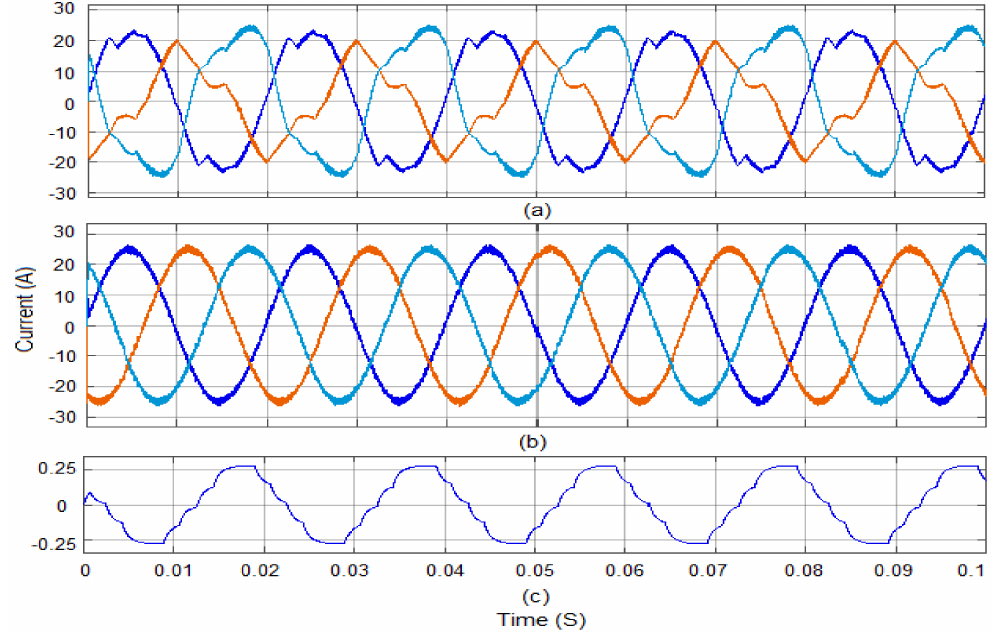
Figure 13. Proposed system with unbalanced load ( a ) output current; ( b ) injected current; and ( c ) neutral current.